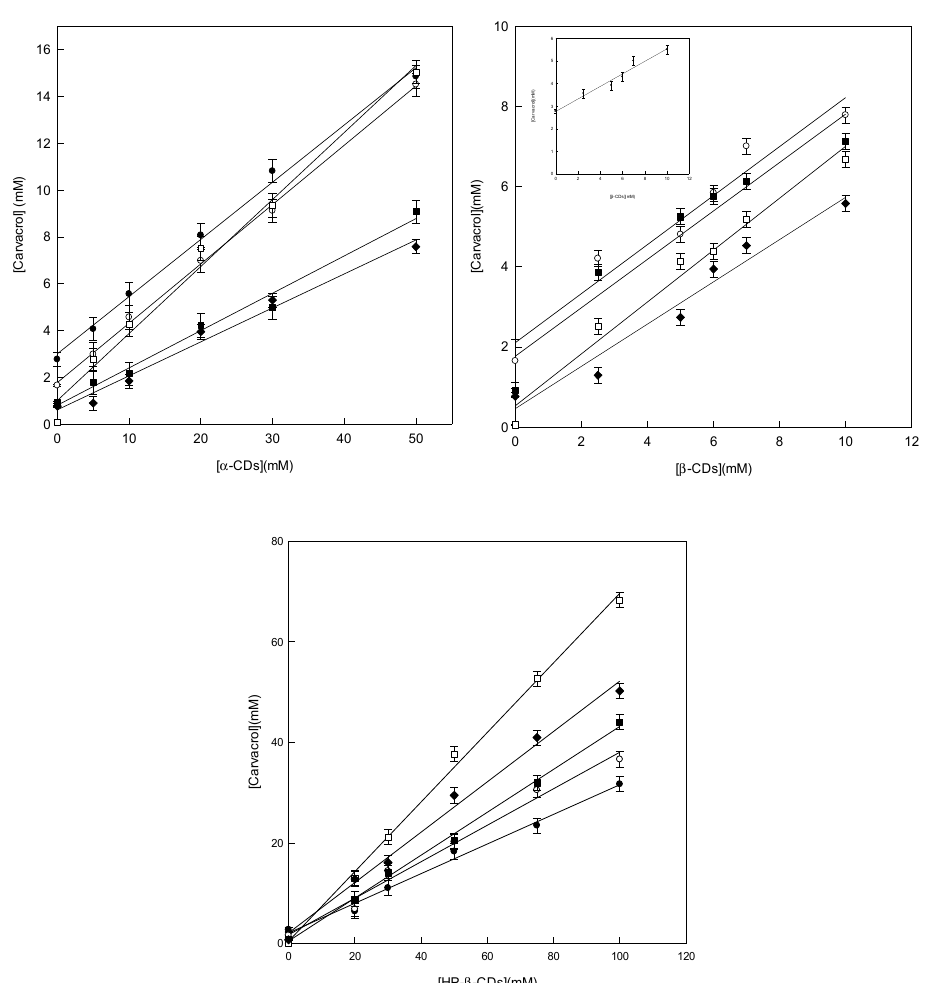
Figure 1. Phase diagrams of carvacrol with α -, β -, and HP- β -CDs at different pH values: pH 3.5 ( • ), pH 5.5 ( ○ ), pH 6.5 ( ■ ), pH 7.0 ( □ ), and pH 8.5 ( ♦ ), at 25 °C. Values represent the means of triplicate determination. Inset pH 3.5 ( • ) at 25 °C. Table 1. Solubility, K C , and complexation efficiency between carvacrol and the various types of CDs at different pHs.